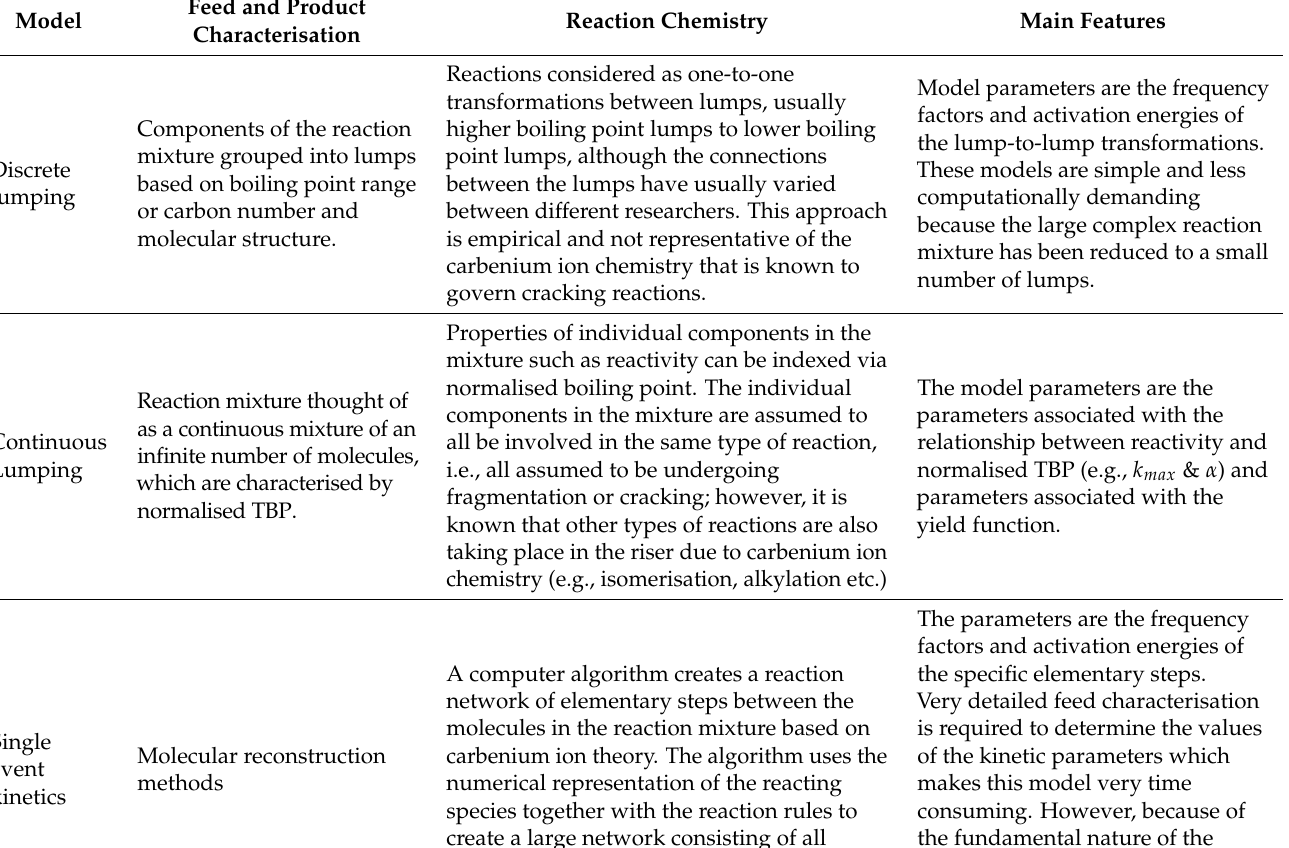
Table 6. Comparitive summary of the different kinetic modelling approaches in FCC riser